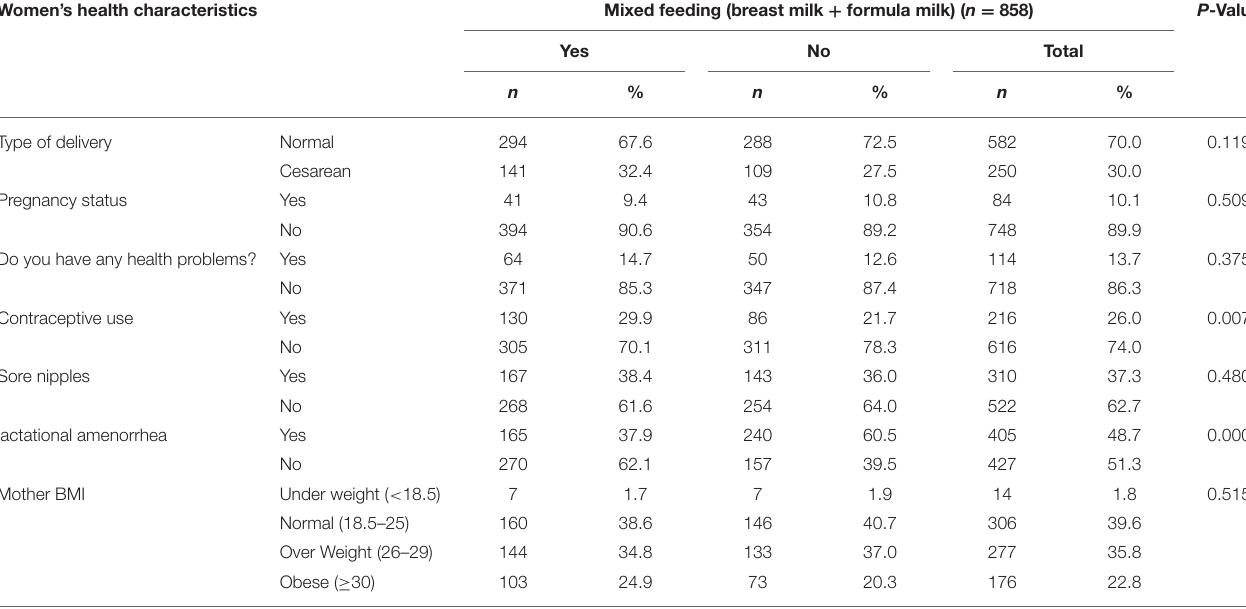
TABLE 5 | Association between mixed feeding (breast milk and formula milk) and women’s health status. Women’s health